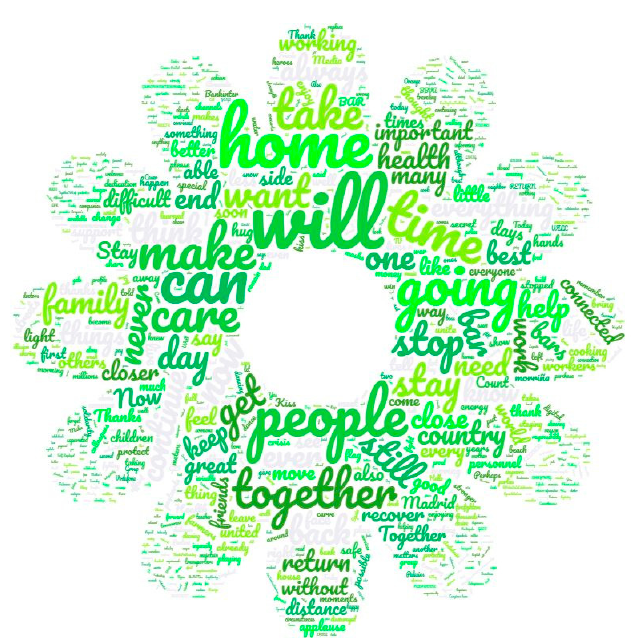
Figure 7. Word cloud of slogans.